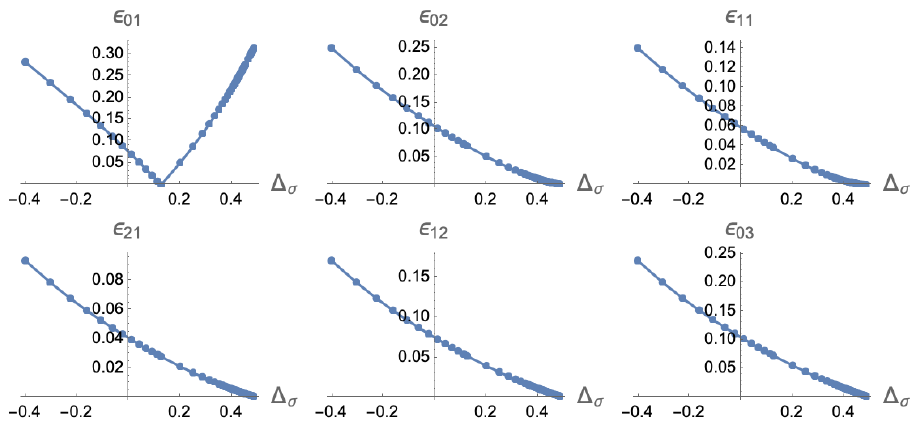
Figure 4: Comparison of eq.(6.6) with exact result.